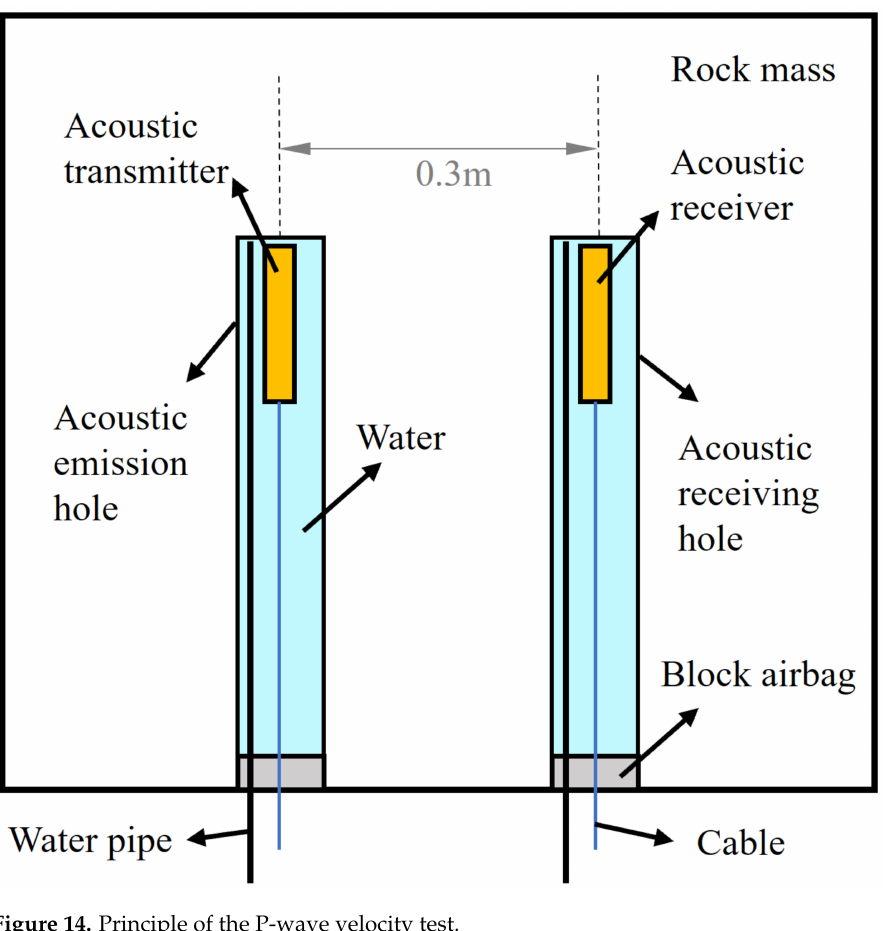
Figure 14. Principle of the P-wave velocity test.